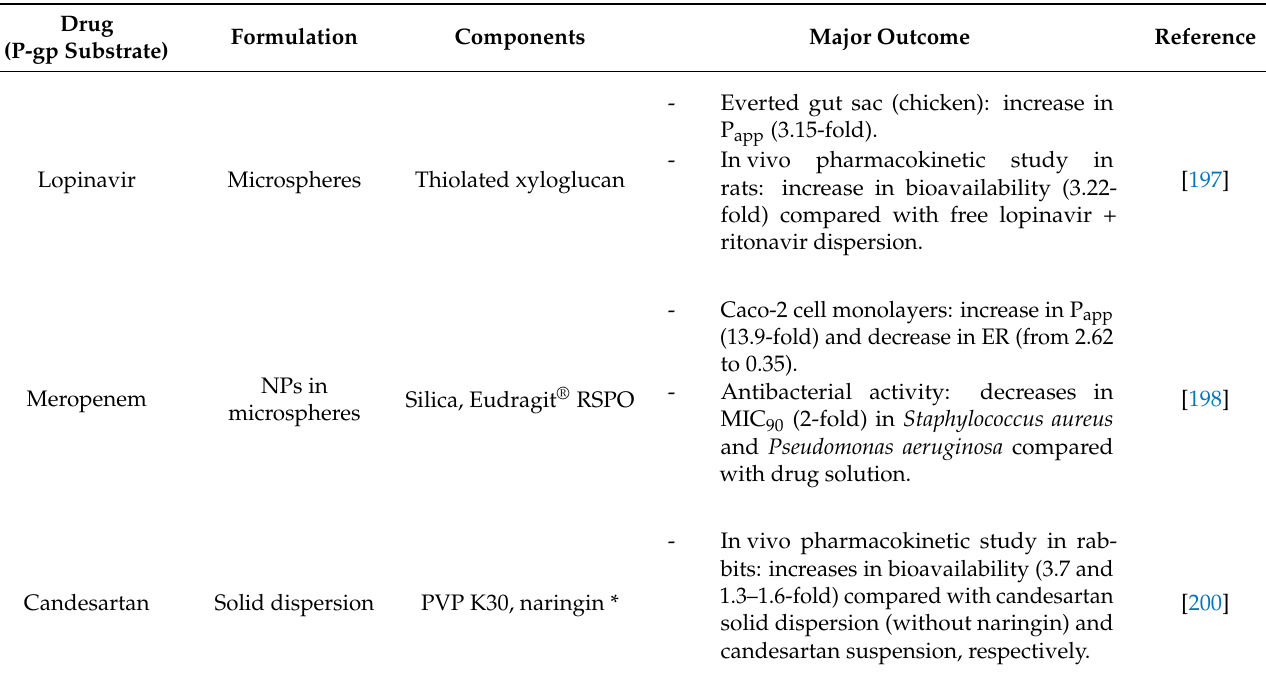
Table 6. Microspheres, solid dispersions, and dendrimers with P-gp inhibitory effects.